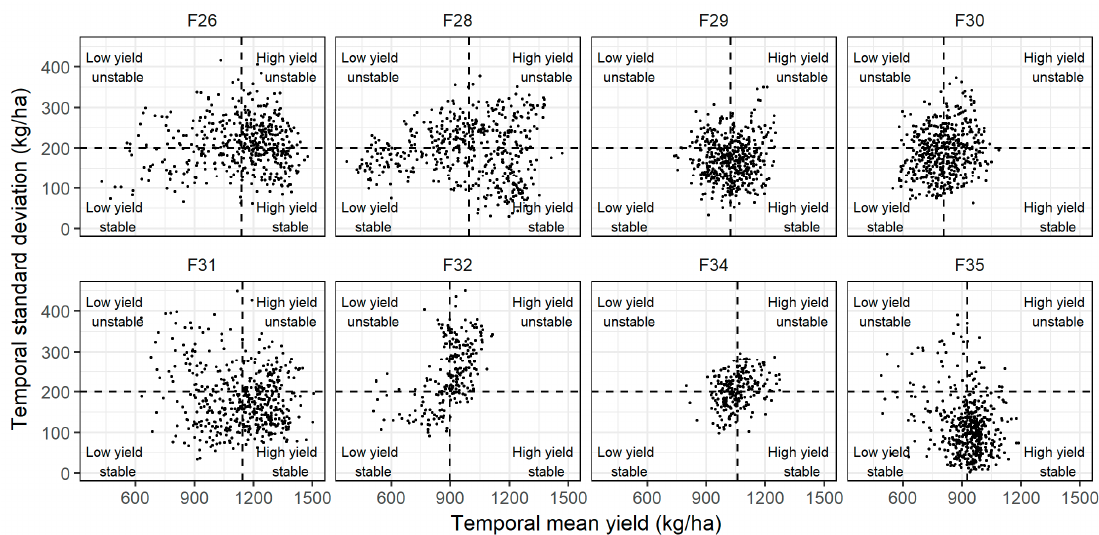
Figure 5. Relationship between temporal standard deviation and temporal mean cotton yield from 2000 to 2003 for eight fields in the Southern High Plains.